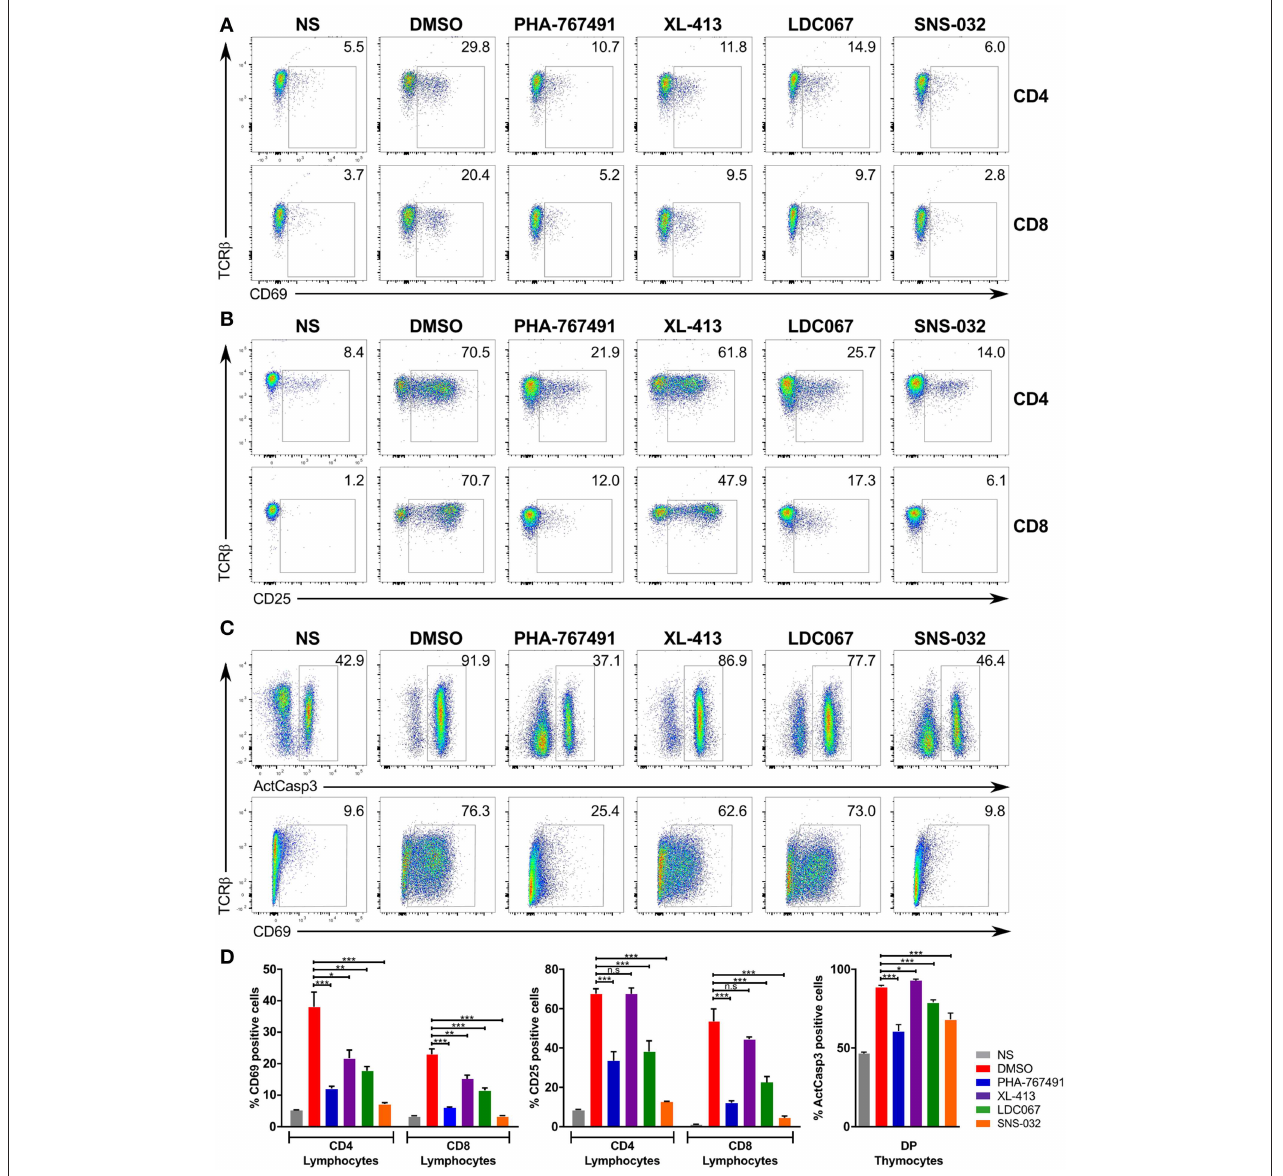
FIGURE 6 | Effects of PHA-767491 inhibition can be reproduced by other Cdc7 and Cdk9 inhibitors. PHA-767491, XL-413, LDC067, and SNS-032 were used to examine the effects of Cdc7 and Cdk9 inhibition in (A) lymphocytes stimulated for 3h, (B) lymphocytes stimulated for 17h, or (C) thymocytes stimulated for 17h. The percentages of the positive population of each sample are shown in the plots. Data shown is representative of at least three separate experiments. (D) The averaged results of the experiments from (A–C) are represented as mean ± SEM. Statistical significance was determined by unpaired two-sided Student’s t -test (ns, non-significant; * p < 0.05; ** p < 0.01; *** p <